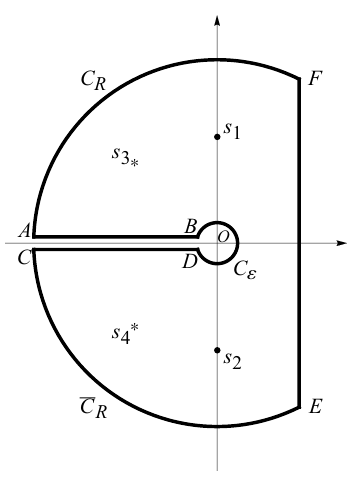
Figure 4. Contour in the fractional